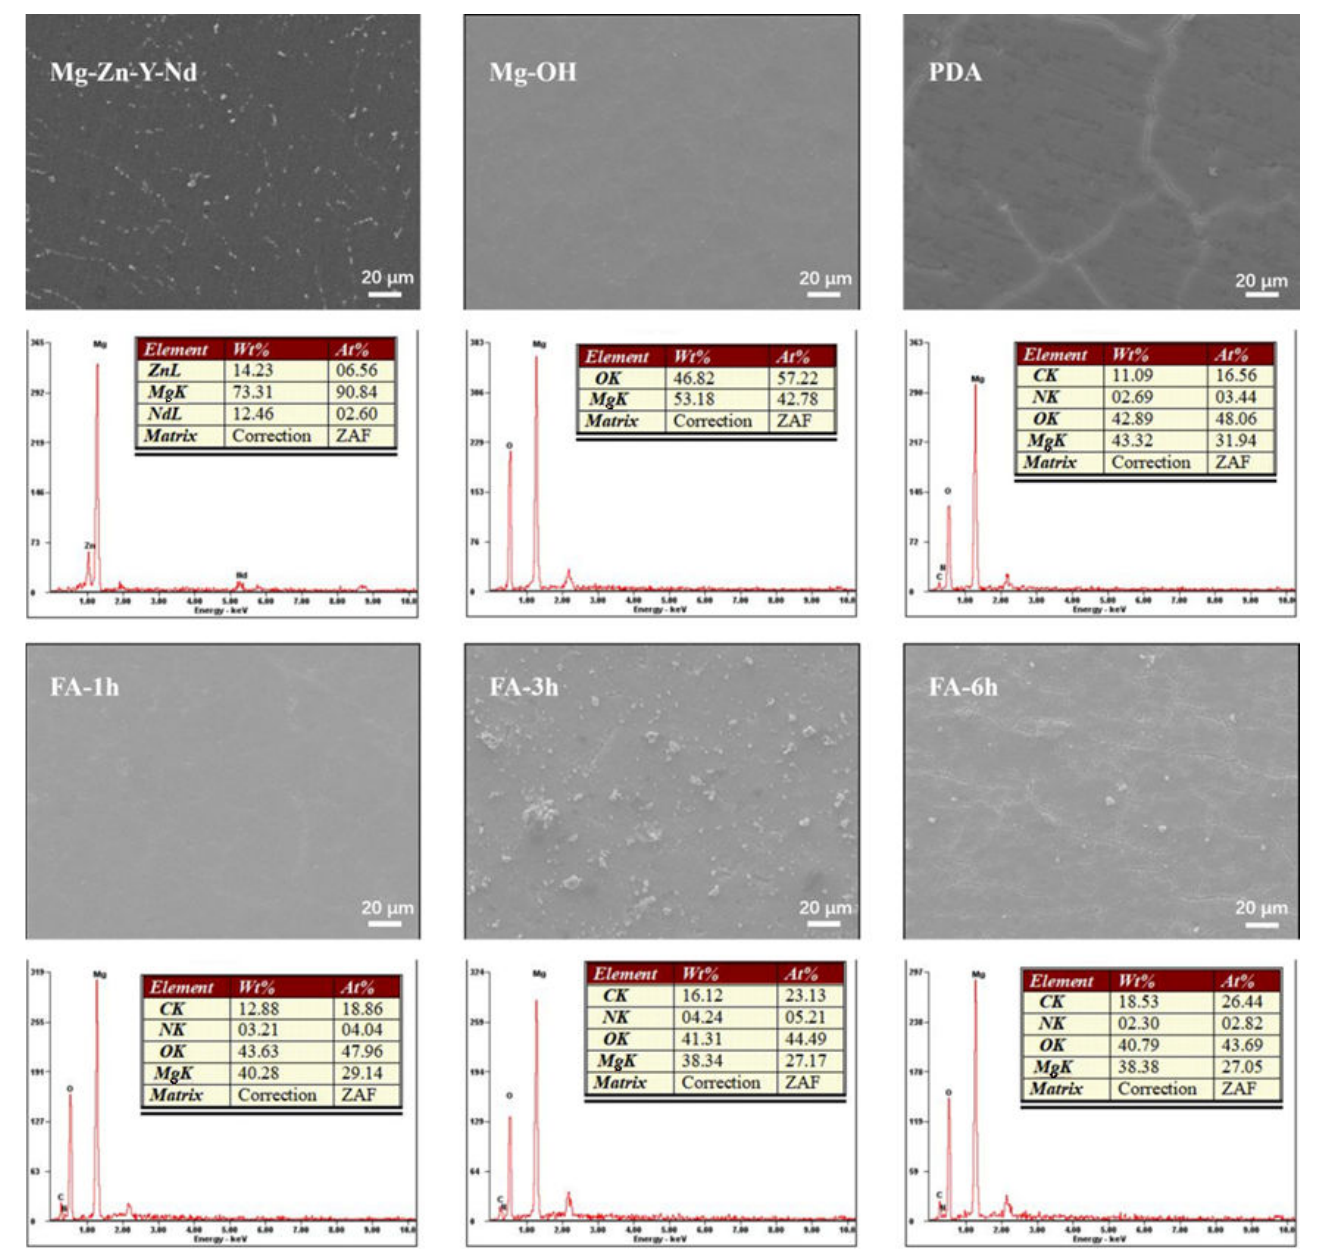
Figure 2. Surface SEM morphology and EDS spectrum of